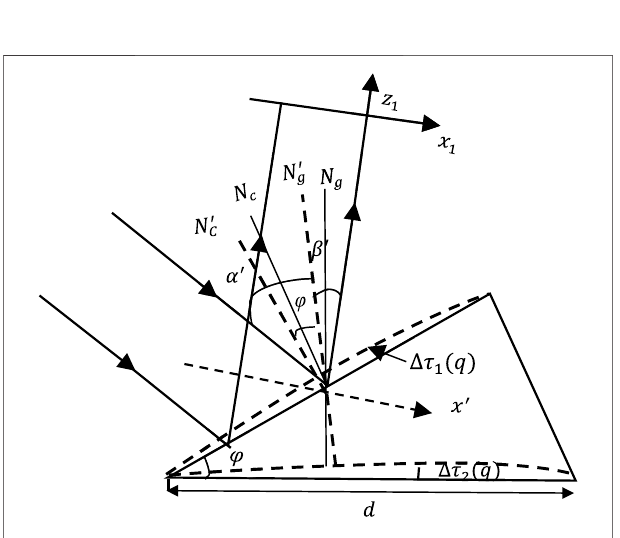
FIGURE 4 | Schematic diagram of optical path difference in the groove.